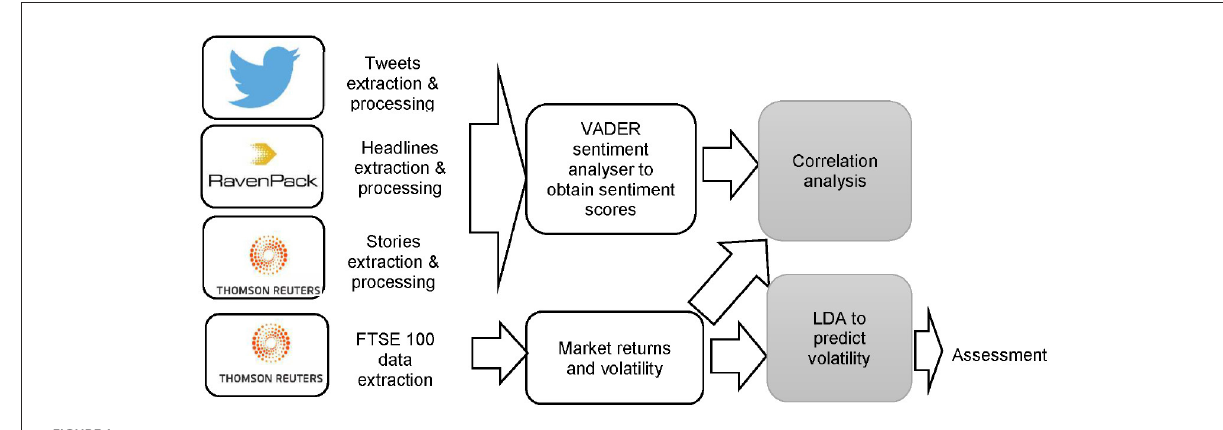
FIGURE1 Overview of our software architecture and